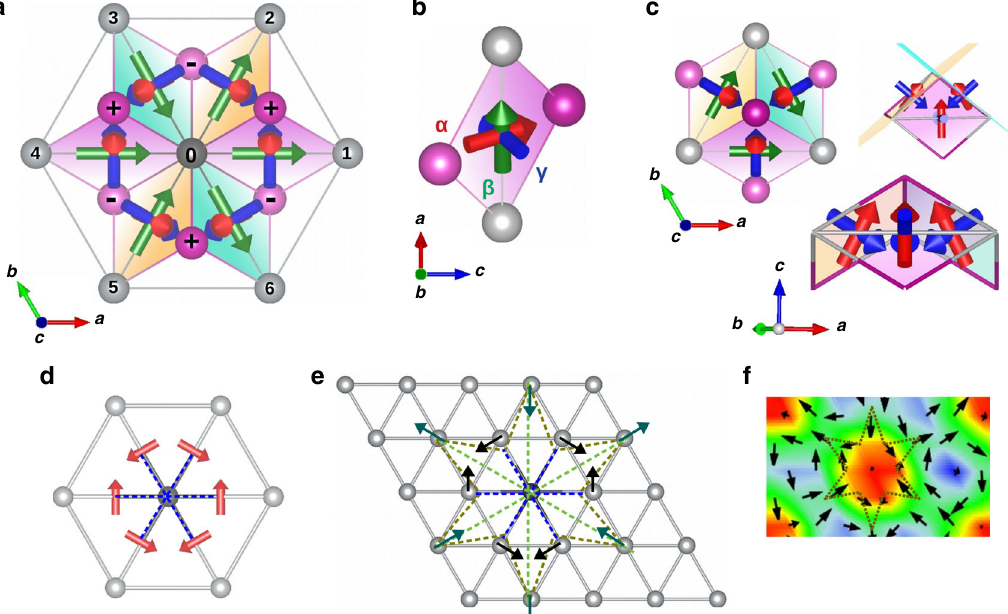
Fig. 2 Schematic visualizations of the magnetic eigenvectors and their relation with the antibiskyrmion spin structure. a Top view of NiI 2 : the six nearest-neighbors Ni surrounding the central Ni atom are labeled with numbers. Plus and minus indicate iodine atoms above and below nickels plane, respectively. The { ν α , ν β , ν γ } eigenvector basis set is represented on each Ni – Ni pair. b Lateral view of the Ni-I – Ni-I plaquette and relative orientation of the eigenvectors: ν α ( α -red), ν β ( β -green), and ν γ ( γ -blue). c Top and lateral view of the local eigenvectors on the triangular Ni-net to help visualization of the noncoplanarity and noncollinearity in the exchange-tensor principal axes. d In-plane components of the ν α eigenvector for each magnetic Ni – Ni pair. e Sketches of the anti-biskyrmion spin structure: spins on the magnetic sites of the nearest-neighbors (black arrows) of the central Ni orient according to the in-plane projection of the noncoplanar principal axes ( d ); spins on the second-nearest neighbor magnetic sites (green arrows) orient following the direction fi xed by the interaction accommodating the A2Sk in a spin lattice. Dashed gold lines are guidelines for the eyes delimiting the topological spin pattern and dashed blue (green) lines mark the direction of the six fi rst (second) nearest neighbor Ni, as in Fig. S2c, d. f Zoom on the antibiskyrmion lattice as obtained from the MC simulations: spins orient as drawn in e